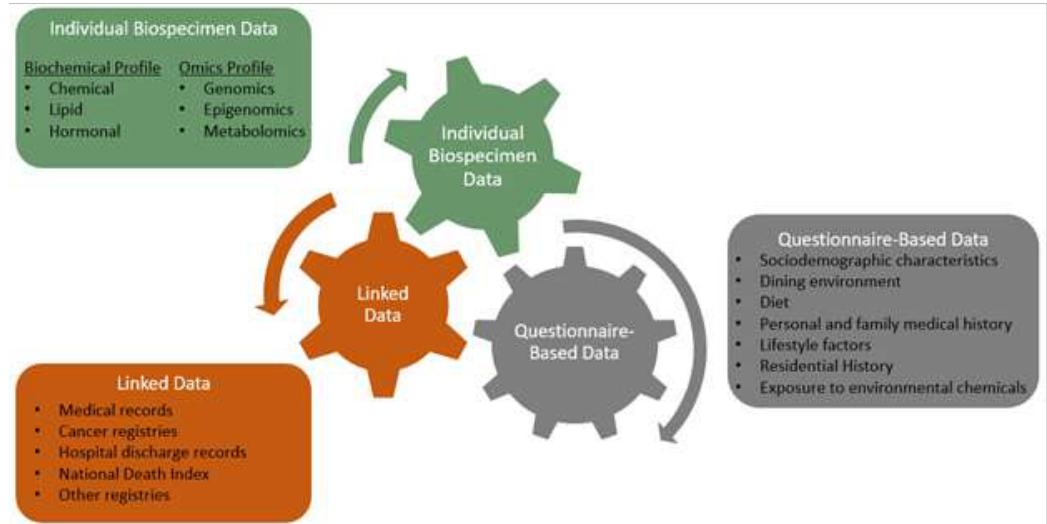
Figure 1. Conceptual model for the MEE Study. The conceptual model includes both completed and potential (future) data collection. At the time of this writing, completed collections include all listed questionnaire-based data, biospecimens, epigenomic profile, urinary levels of glyphosate, organophosphate pesticides, and bisphenols A and S, and mammogram reports.